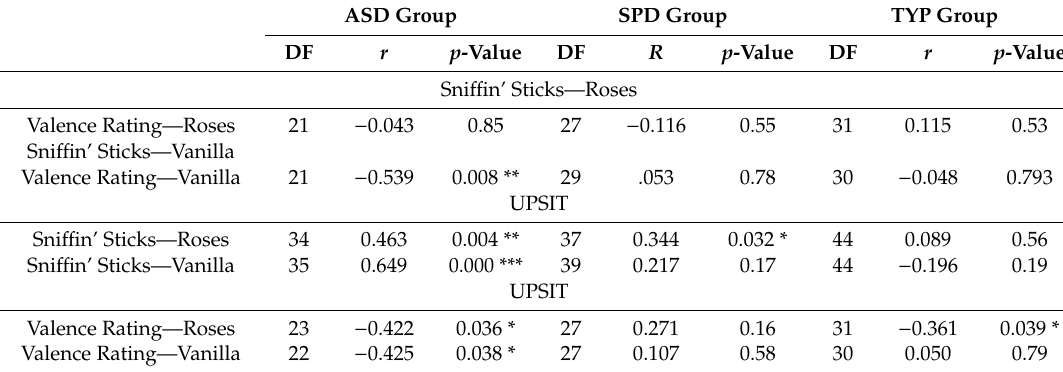
Figure 4. Mean odor identification scores by group, as measured by University of Pennsylvania Smell Identification Test (UPSIT). Error bars indicate standard deviation. ( * ) denotes significant at p < 0.01 ( ** ) denotes significance at p < 0.001. ASD = children with Autism Spectrum Disorder; SPD = children with demonstrated Sensory Processing Dysfunction; TYP = Typically Developing children. Table 4 contains results for the correlation analyses between the different olfactory metrics. Table 4. Correlations between olfactory metrics.